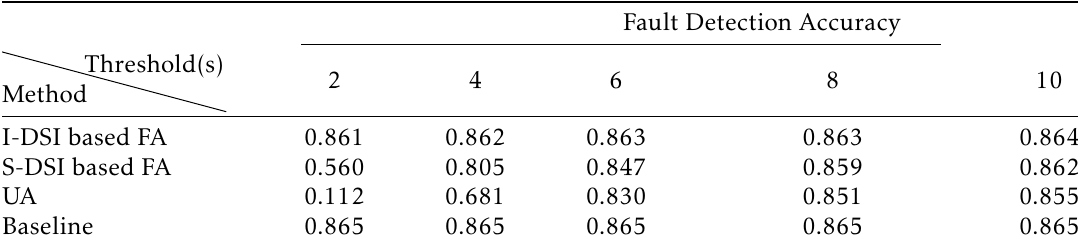
Table 5. Impact of latency limit on the FA schemes along with